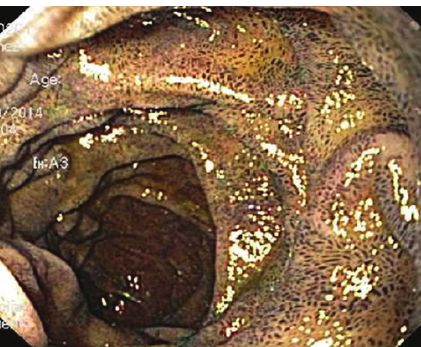
Figure 1: Endoscopic examination of duodenum showing dark speckled appearance of duodenal mucosa.